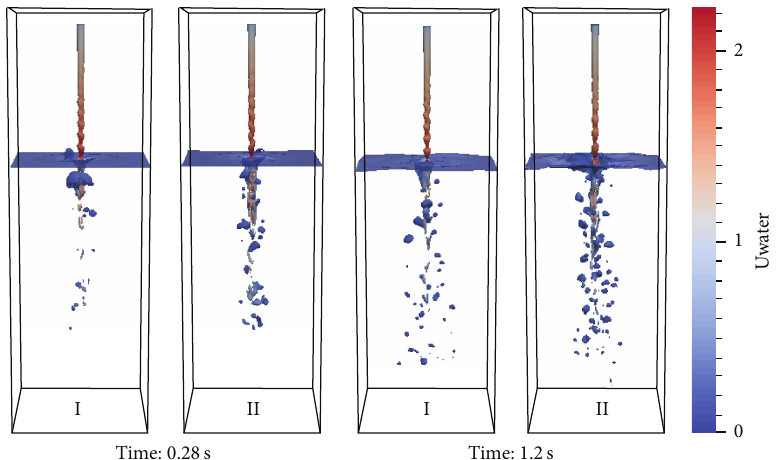
Figure 4: Comparison of snapshots at two times for the simulations using different diameters: Case I ( 𝑑 = 2 mm) and Case II ( 𝑑 = 500 𝜇